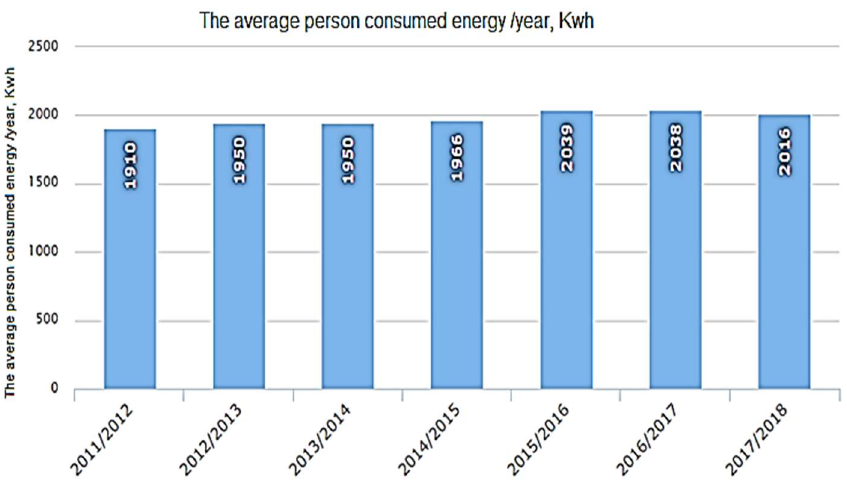
Figure 6. The average person consumed energy/year, kWh [72].